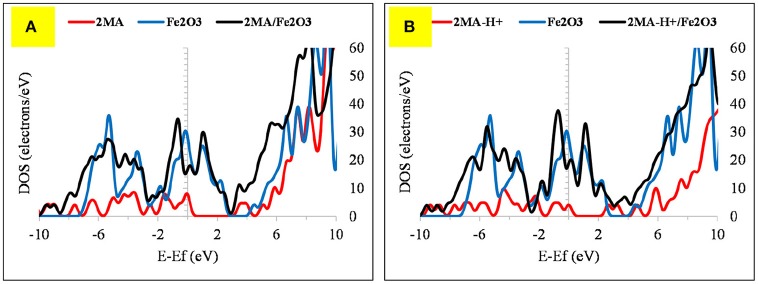
The DOS plot for: (A) 2MA, Fe2O3 and 2MA/Fe2O3 and (B) (A) 2MA-H+, Fe2O3 and 2MA-H+/ Fe2O3 cluster system.